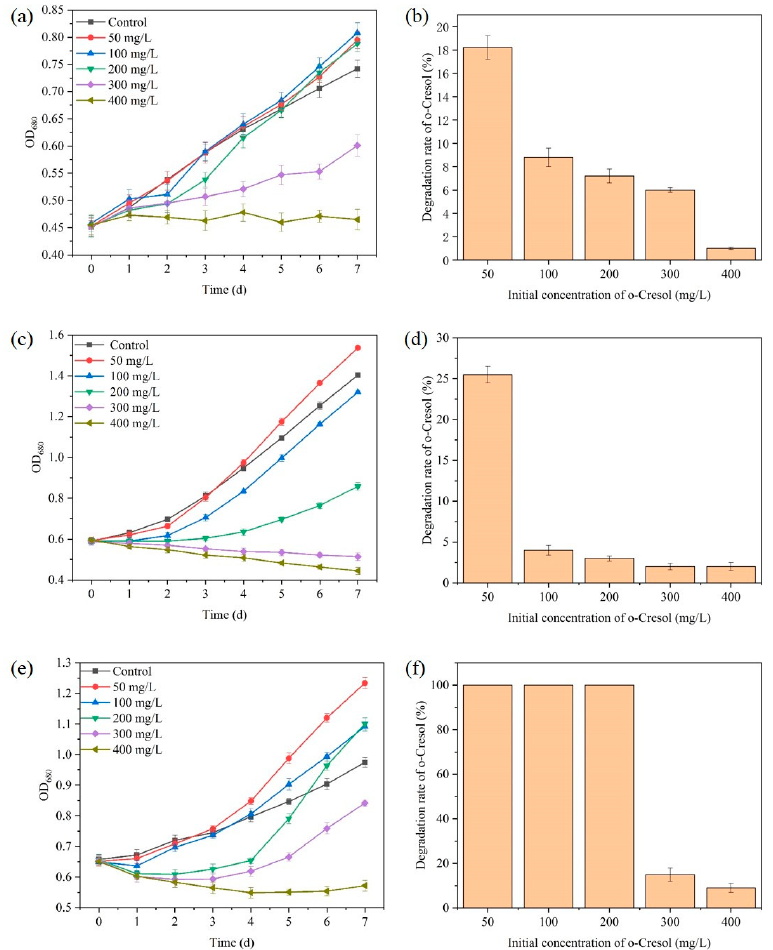
Figure 1. Growth of three microalgae strains of Scenedesmus obliquus , Microcystis aeruginosa , and Selenastrum capricornutum and changes in the concentration of o-cresol. ( a ) Growth curve of Scenedesmus obliquus ; ( c ) growth curve of Microcystis aeruginosa ; ( e ) growth curve of Selenastrum capricornutum ; ( b ) o-cresol degradation rate by Scenedesmus obliquus ; ( d ) o-Cresol degradation rate by Microcystis aeruginosa ; ( f ) degradation curve of o-cresol by Selenastrum capricornutum